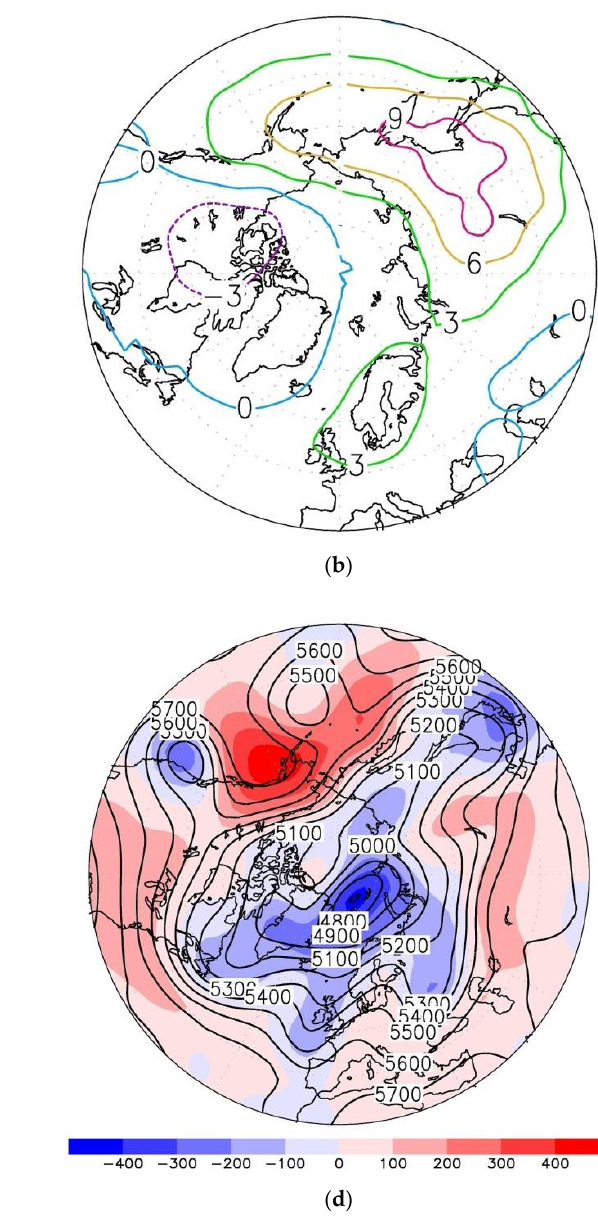
Figure 5. Vertical component of Plumb fluxes Fz (m 2 /s 2 · 10 −2 ) at 100 hPa over 7 February - 7 March 2020 ( a ) and corresponding climate mean over 1981–2010 ( b ). Solid contours correspond to positive values, dashed - negative. Contour interval is 3. The same but averaged over 14–16 March 2020. Contour interval is 10. ( c ), geopotential height (contours) and its anomalies from climate mean (gpm) (color scale) at 500 hPa on 16 March 2020 ( d ).